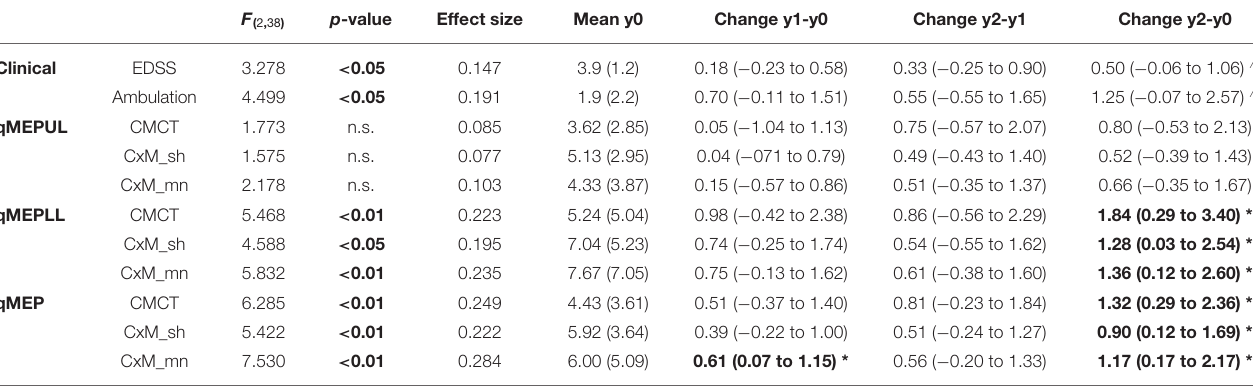
TABLE 1 | Analysis of longitudinal change in EDSS, ambulation and qMEP